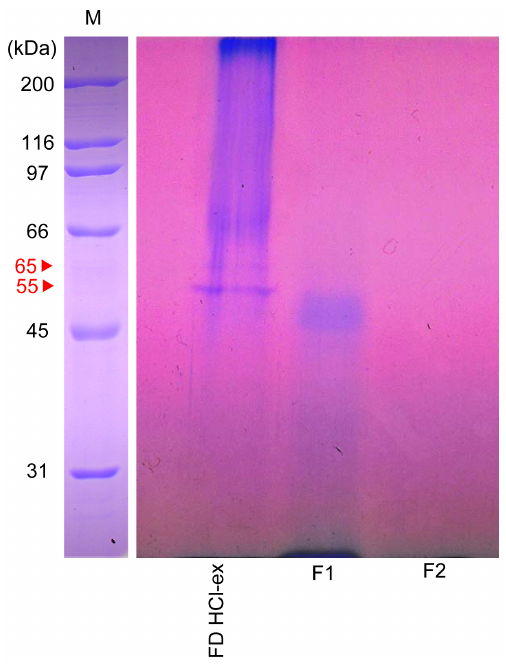
Figure 9. SDS-PAGE gel image of C. gigas FD HCl-ex, F1 (fraction 1) and F2 (fraction 2) stained with Stains-all. SDS-PAGE was performed on 10% polyacrylamide gels; 10 m g protein content was loaded in each lane. M indicates the molecular weight markers. Molecular weights were estimated using the molecular weight marker ‘‘Broad Range’’